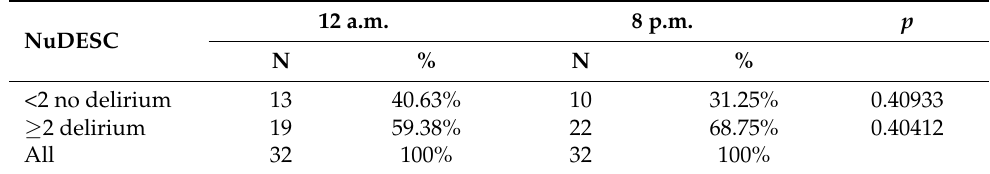
Table 1. Characteristics of the distribution of delirium syndrome according to the Nursing Delir- ium Screening Scale (NuDESC). Table 2. Characteristics of groups according to the Delirium Observation Screening Scale (DOSS) in the examined